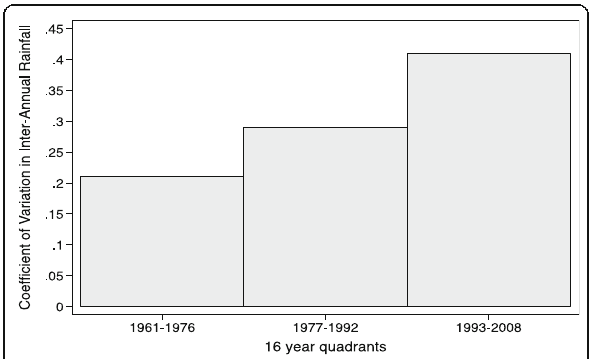
Figure 8 Changes in coefficient of variation (CV) in rainfall for the Ilmotiok and Tiamamut GR, 1961 to 2008. Although CV increases linearly over time, the increases are not statistically significant ( p < 0.08)